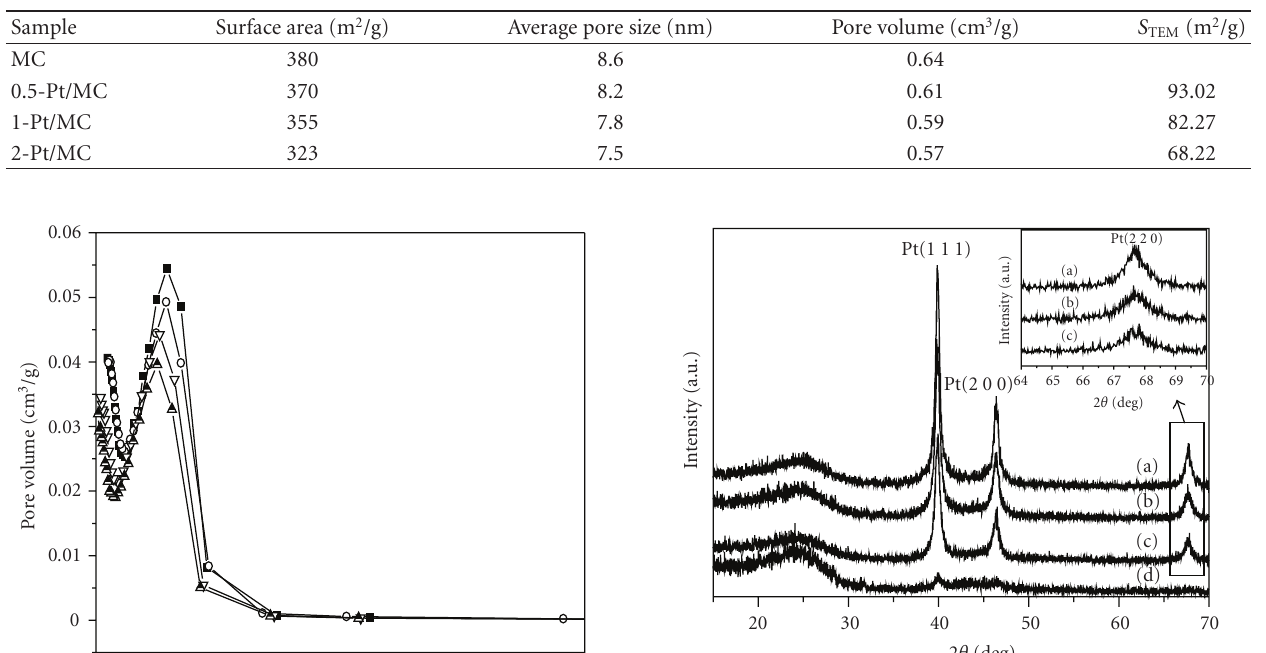
Table 1: Surface area, average pore size, and pore volume for MC and Pt/MC samples and the specific surface area of Pt particles for Pt/MC samples.